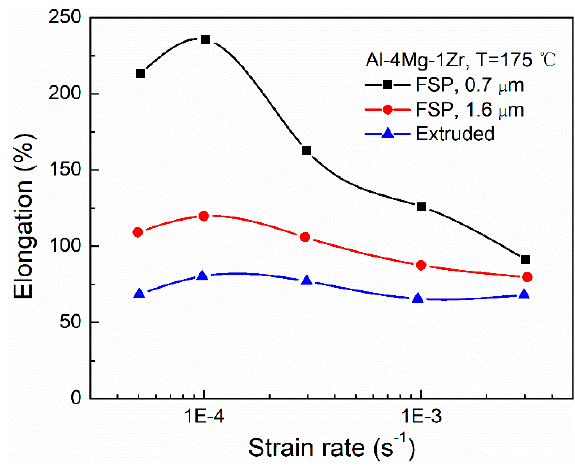
Figure 2. Variation of elongation with strain rate and grain size, reproduced from [67], with permission from Elsevier, 2005.